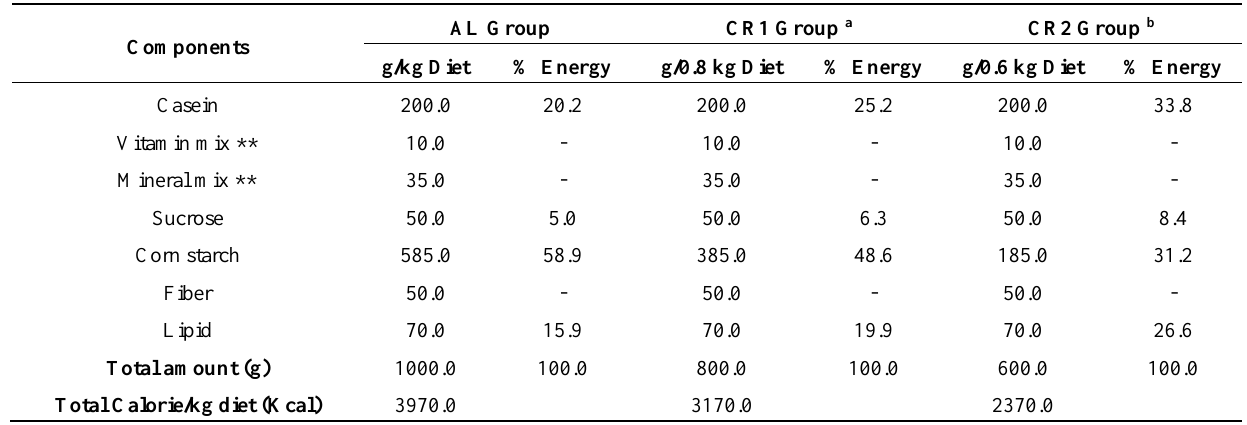
Table 1. Composition of rat chow diet